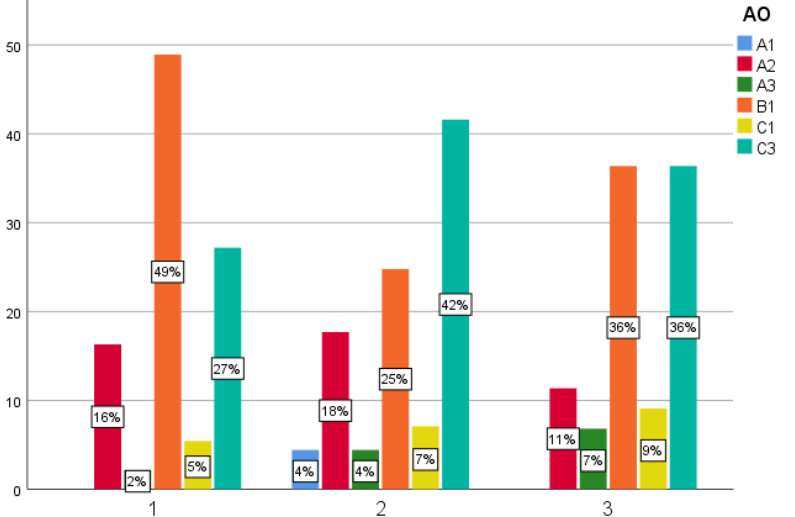
Figure 5. Different treatment options (1 = NCB, 2 = Philos, 3 = Philos-augmented) divided according to the AO classification ( x axis) in percent ( y axis).